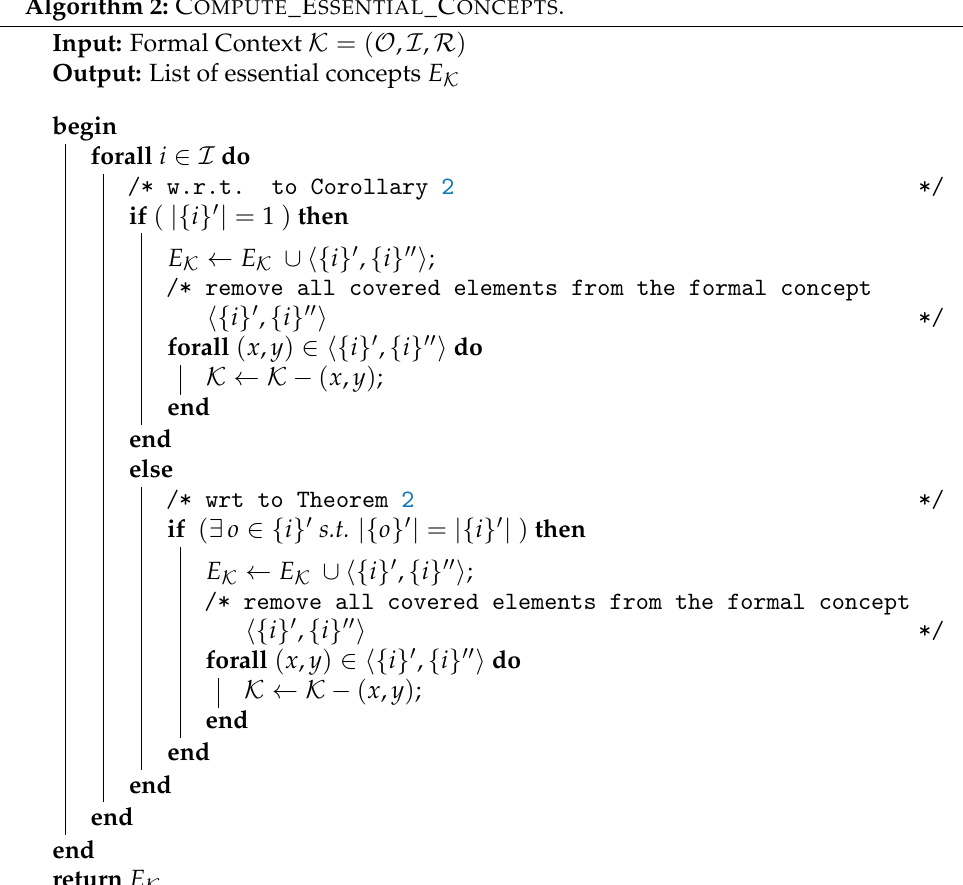
Algorithm 2: C OMPUTE _E SSENTIAL _C ONCEPTS